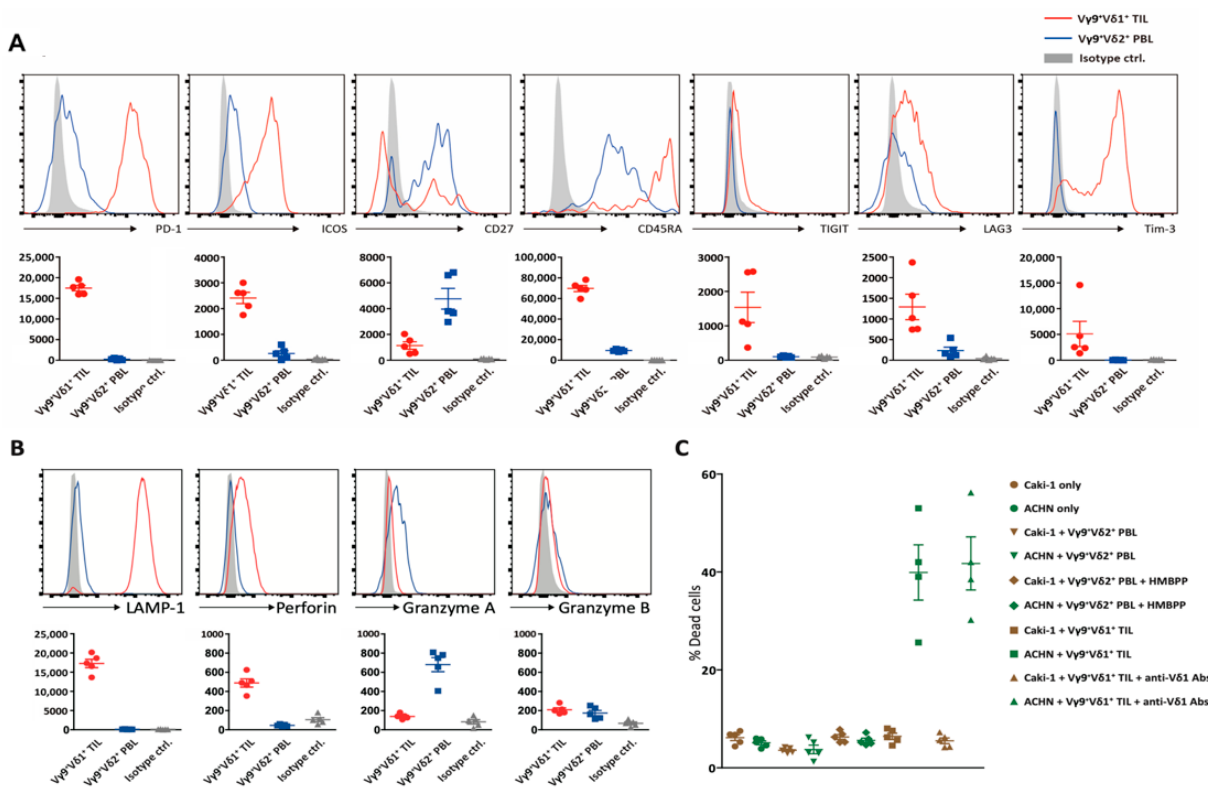
Figure 4. Immune modulation and cytotoxic activity. ( A ) The proportions of dead cells were shown for the cytotoxicity assays using two RCC cell lines and sorted γδ T cell populations as mean ± SD. ( B ) V γ 9+- δ 1+ TILs and V γ 9+- δ 2+ peripheral blood lymphocytes (PBLs) were compared for the expression of co-stimulatory molecules (ICOS and CD27), immune checkpoint receptors (PD-1, TIGIT, LAG3, and TIM-3) and CD45RA. Shaded histograms show the staining of the negative controls. Values from all patients are shown as dot graphs with mean ± SD and statistical significances. ( C ) Cytotoxic activity of intra-tumoral V γ 9 δ 1 T cells.